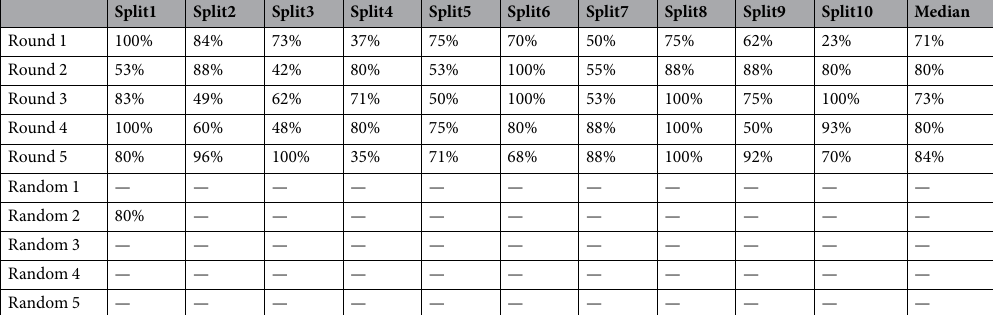
— — — — — — — — — — — — — — — — Table 1. Results from 10-fold cross validation. We used the sTRA-only, CA19-9-only, and dual-labeled tissue markers to seek panels that distinguish 30 short-TTP samples from 15 long-TTP samples (Fig. 6). Each value is the average accuracy of the panels from the training set applied to the set-aside test samples for each split (see Materials and Methods for details). The average of the medians from the five independent rounds was 78%. For the rounds marked ‘Random’, we randomly assigned a case or control status to each of the 45 samples and repeated the process. Except for Split1 of the second round, the program did not find any panels that met the minimum performance in the training